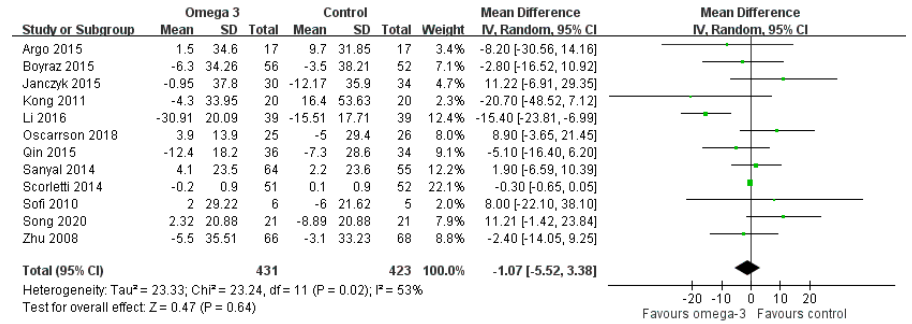
Figure 5. Effects of omega-3 fatty acid on serum lipid profiles. ( A ) Effect on total cholesterol. ( B ) Effect on triglyceride. ( C ) Effect on high-density lipoprotein cholesterol. ( D ) Effect on low-density lipoprotein cholesterol.